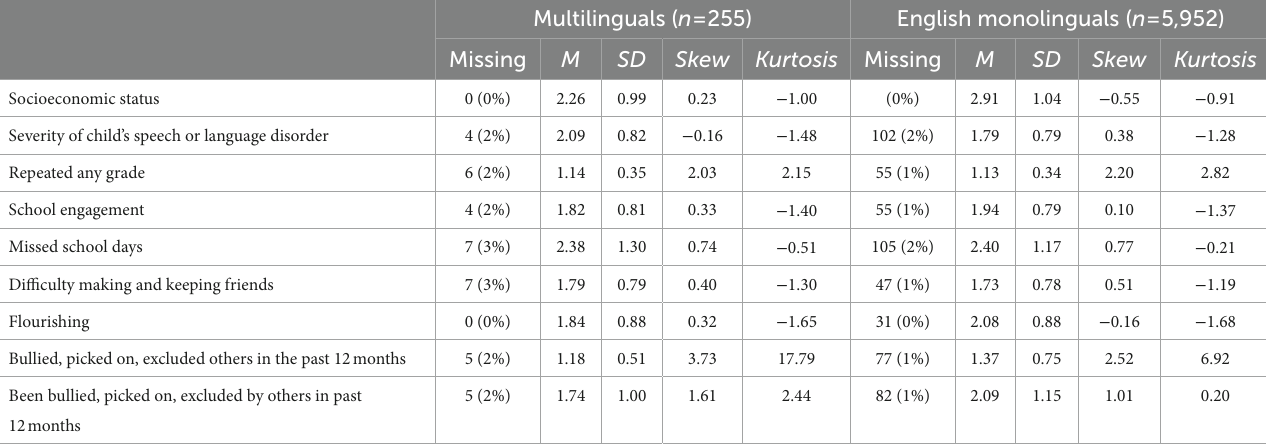
TABLE 3 Sample’s descriptive statistics by group.